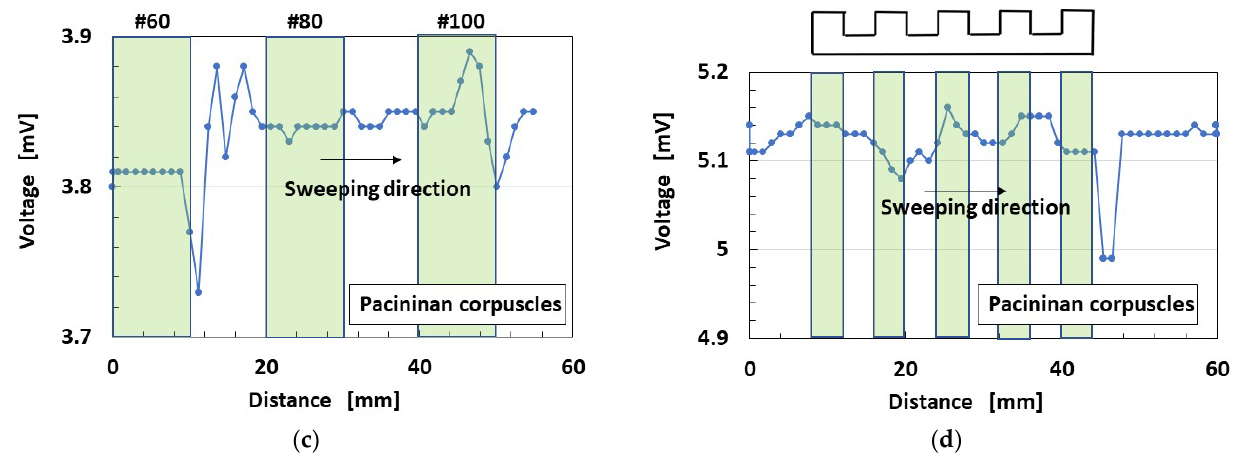
Figure 8. Experimental results of tactile and thermal sensing obtained in different cases: when ( a ) applying a normal force; ( b ) touching a heater; ( c ) applying a shear force on intermittently positioned sandpaper; ( d ) applying a shear force on a convex–concave-shaped body.